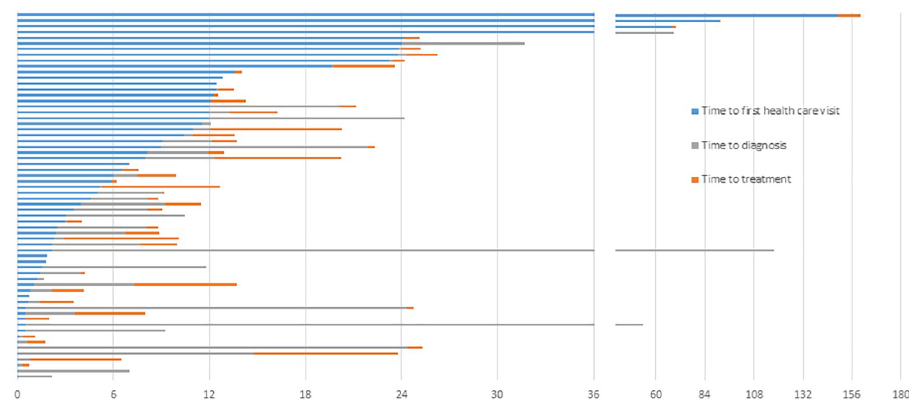
Fig 1. Distribution of the three consecutive time intervals in months (time to first healthcare visit, time to diagnosis and time to treatment) for each patient ( N = 64).